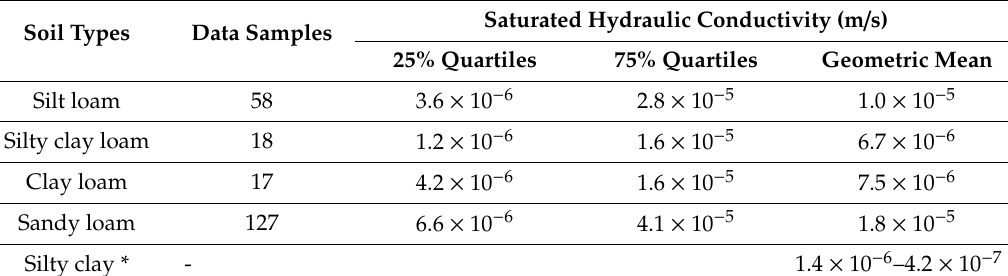
Table 2. Saturated hydraulic conductivity for soils with low bulk density (data modified from